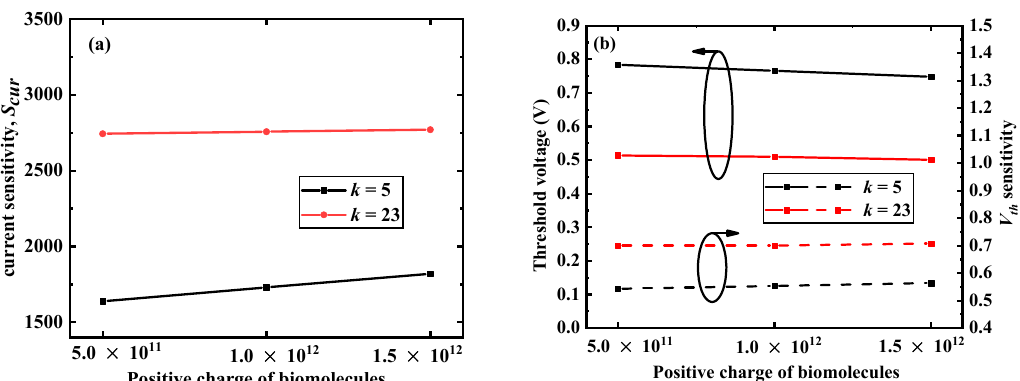
Figure 7. ( a ) Effect of different positive charges of the biomolecules on the current sensitivity and ( b ) V th and S Vth of the DM-LTFET at V g = 1 V, V d = 0.5 V, k = 2.5 and 23, and T c = 5 nm.